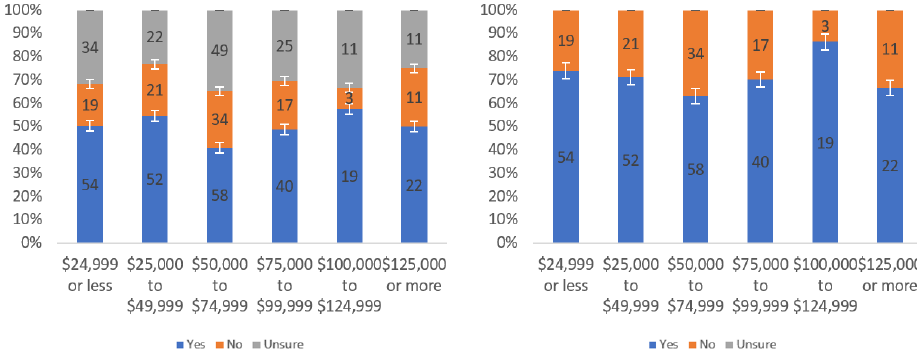
Figure A25. Responses regarding others’ willingness to review by income level including ( left ) and excluding ( right ) unsure responses.